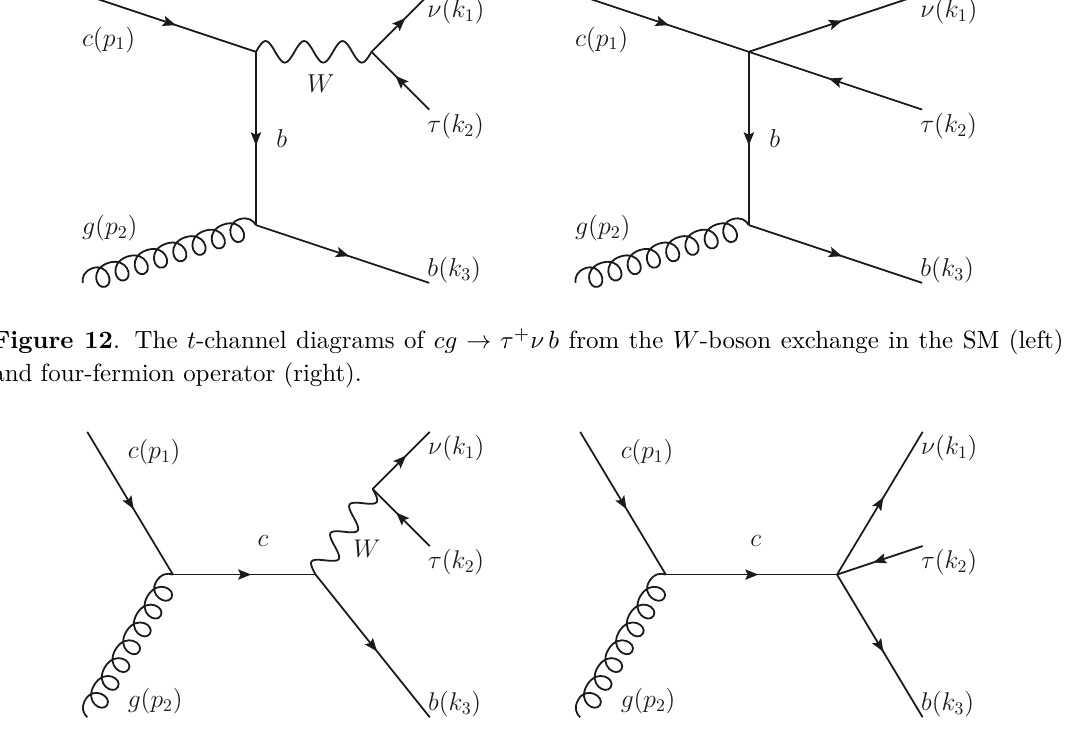
Figure 13 . The s -channel diagrams of cg → τ + ν b from the W -boson exchange in the SM (left) and four-fermion operator